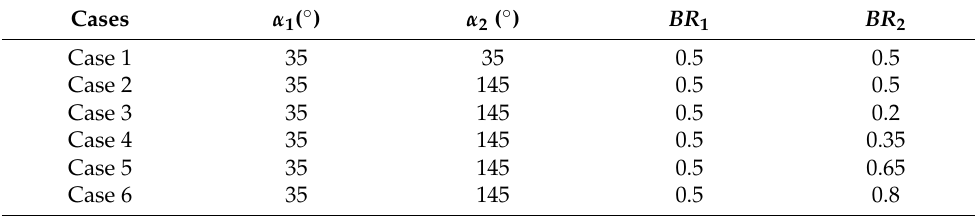
Figure 1. Flow configuration for double rows film cooling with the combination of forward and backward jets. Table 1. Parameters list of simulation cases.